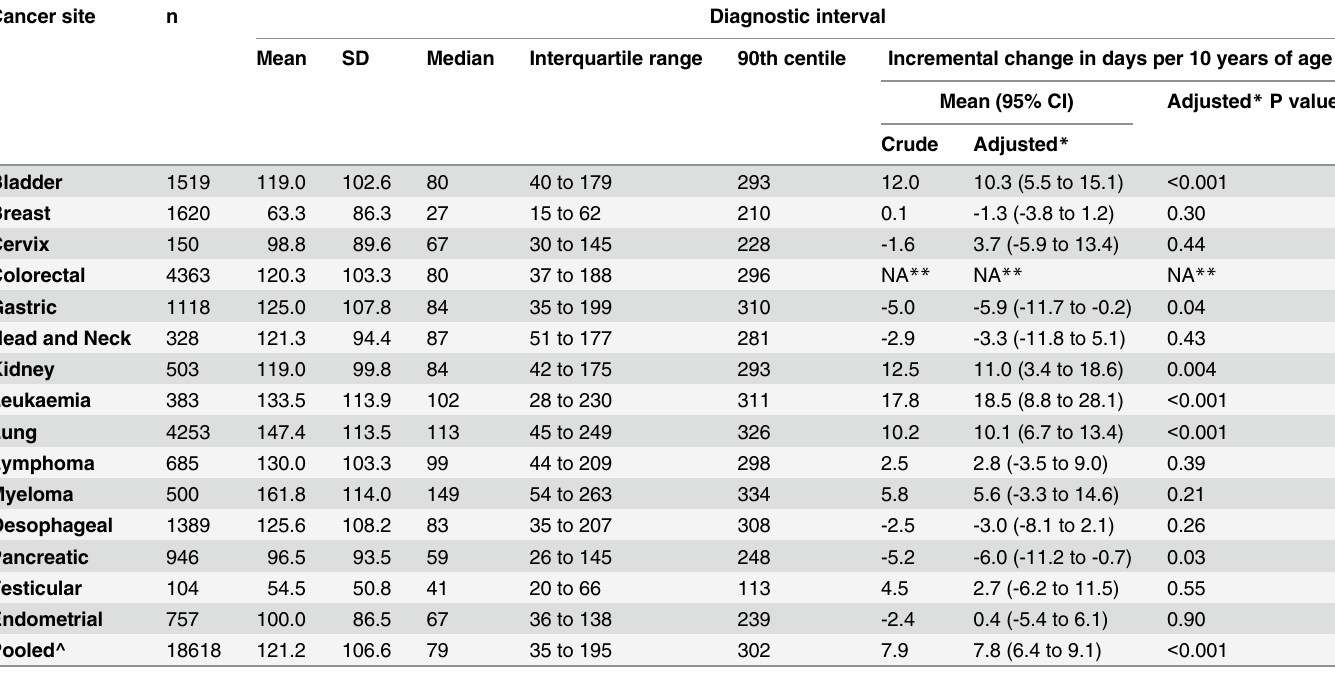
Table 2. Regression analysis of diagnostic intervals against age * in 15 cancers.